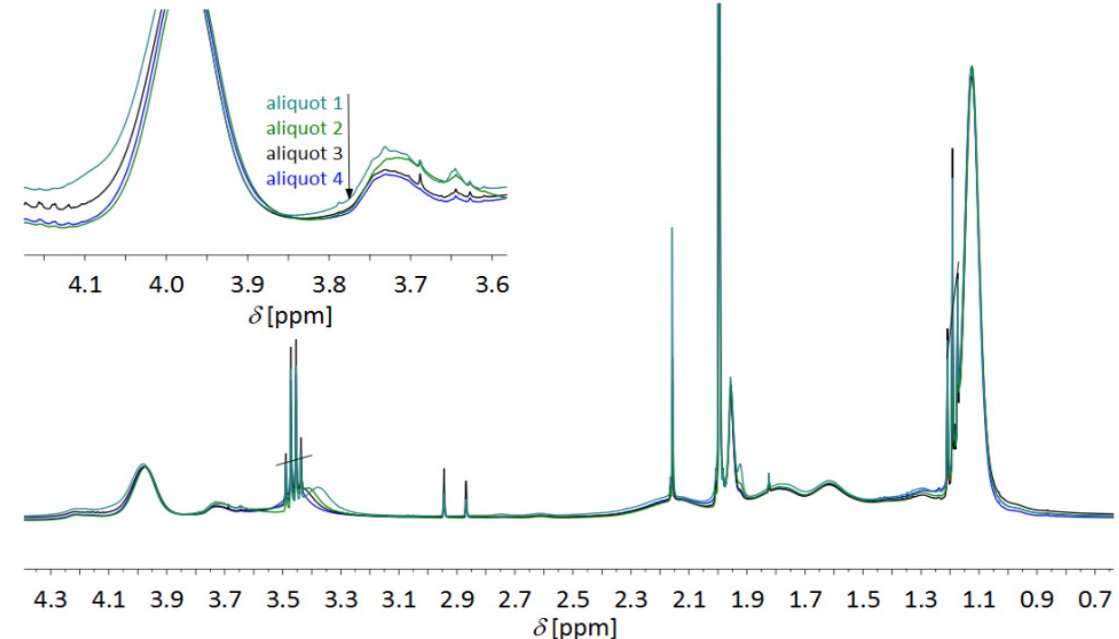
Figure 19. Superimposed, standardized 1 H NMR spectra recorded in CDCl copolymerization with 5,000 mmol·L − 1 NIPAm and 280 mmol·L − 1 1.1 using 0.6 mmol·L −